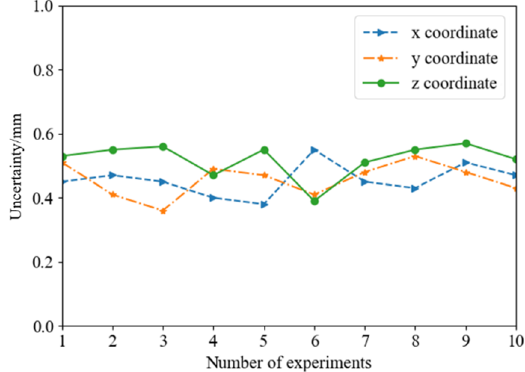
Figure 13. Analysis of online hand–eye calibration